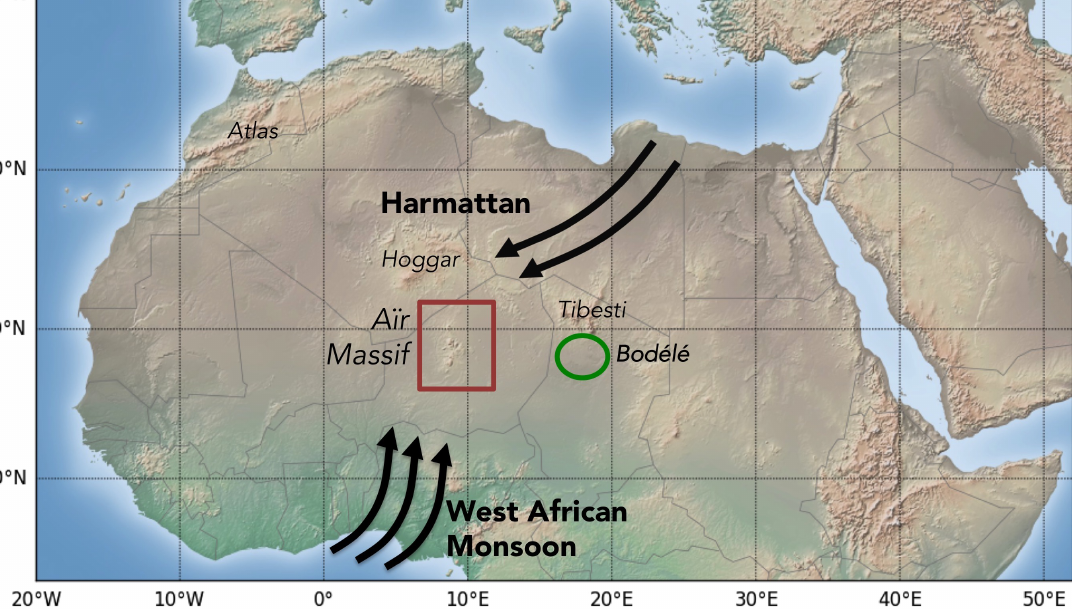
Figure 1. Overview of the location of the study area, the Bodélé depression, and the main Saharan mountain ranges, as well as the location of the West African Monsoon and Harmattan